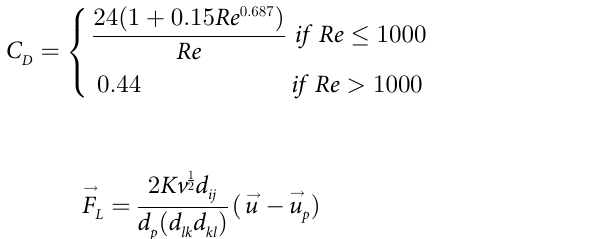
where Re is the Reynolds Number, K is a constant equal to 2.594, v is the kinematic viscosity, is the deformation tensor, d d i , j ! is the velocity of the platelet. u p